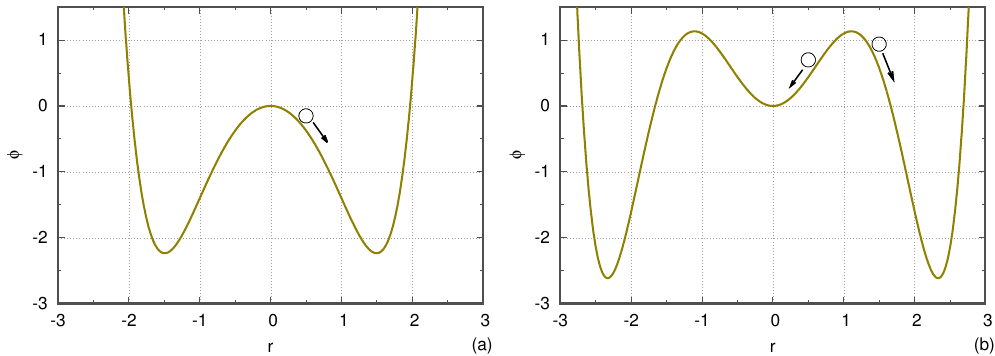
Figure 1. Cartoon of the concept of supercritical and subcritical instabilities. The solid curve is a fixed potential. ( a ) Supercritical case: a = 1.5, b = 0, and c = 0.1. The equilibrium r = 0 is unstable. ( b ) Subcritical case: a = − 2, b = 1, and c = 0.1. The equilibrium r = 0 is stable to small perturbations (circle and arrow at r = 0.5) but unstable to perturbations with an amplitude above a certain threshold (circle and arrow at r =